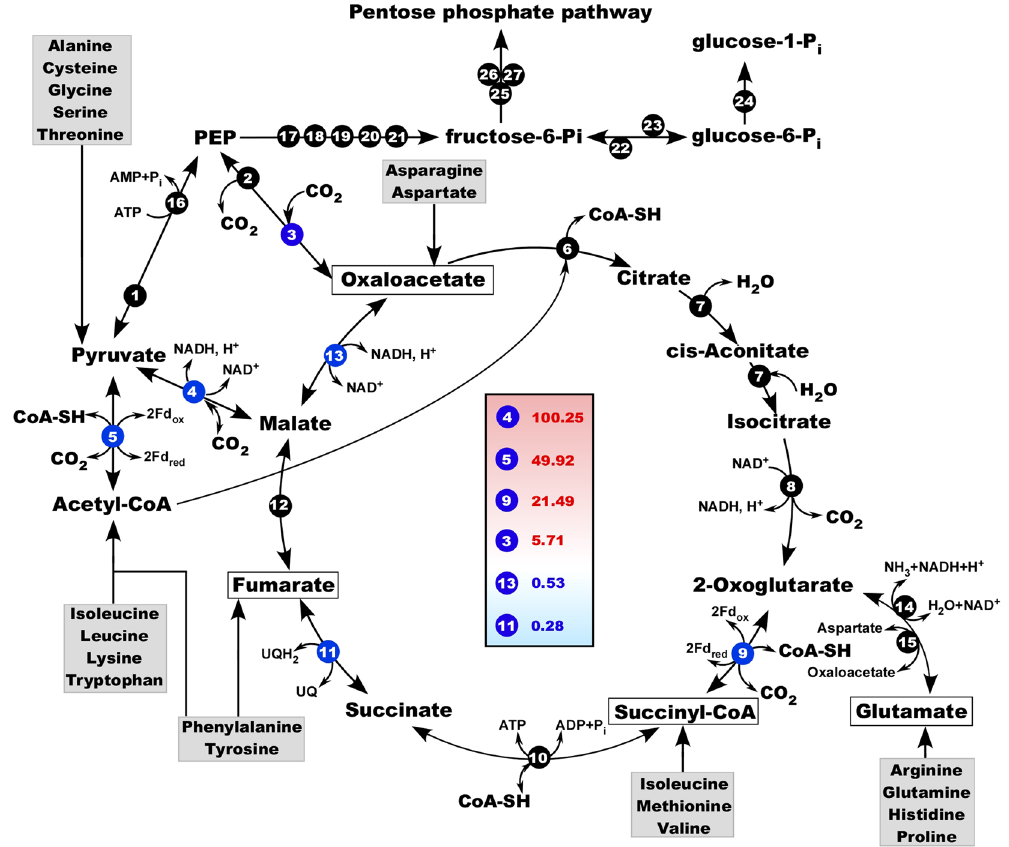
Figure 4. Proposed citric acid cycle and related enzyme reactions in F. acidiphilum Y T . The enzymes are as follows: 1, pyruvate kinase (FAD_1603); 2, PEP carboxykinase (FAD_1050); 3, PEP carboxylase (FAD_1044); 4, NAD-binding malic enzyme/malate dehydrogenase (FAD_0703); 5, pyruvate: ferredoxin oxidoreductase (FAD_0567–0568); 6, citrate synthase (FAD_1100); 7, aconitate hydratase (FAD_0701); 8, isocitrate dehydrogenase (FAD_1632); 9,2-oxoglutarate:ferredoxin oxidoreductase (FAD_0712–0713); 10, succinyl- CoA synthetase (FAD_0709–710); 11, succinate dehydrogenase (FAD_0714–0717); 12, fumarate hydratase (FAD_1630); 13, malate dehydrogenase (FAD_0718); 14, glutamate dehydrogenase (FAD_0434); 15, aspartate aminotransferase (FAD_1098); 16, phosphoenolpyruvate synthase (FAD_1233); 17, phosphoglycerate mutase (FAD_0440, FAD_1169, FAD_1350); 18,2-phosphoglycerate kinase (FAD_1810); 19, glyceraldehyde- 3-phosphate dehydrogenase (FAD_0549); 20, triosephosphate isomerase (FAD_0107); 21, fructose-2,6- bisphosphatase (FAD_0332); 22,6-phosphofructokinase (FAD_0353); 23, bifunctional phosphoglucose/ phosphomannose isomerase (FAD_0562); 24, phosphoglucomutase/phosphomannomutase (FAD_0602); 25, transketolase (FAD_1477–1476); 26, transaldolase (FAD_1201; FAD_1475); 27, ribulose-phosphate 3-epimerase (FAD_0295). Abbreviations used: Fd, electron carrier ferredoxin; NAD, nicotinamide adenine dinucleotide; CoA, Coenzyme-A; PEP, phosphoenolpyruvate; UQ, ubiquinone. Enzymes labeled in blue are potentially involved in anaplerotic assimilation of CO 2 . Their relative expression levels, analysed by RT-qPCR and indicated by the numbers in the central box, were obtained by normalization of the total RNA added and using transcripts of DNA gyrase subunit B ( gyr B) as the internal reference (value 1.0). Normalization using gyr B was additionally validated vs transcripts of gene for ribosomal L2 protein. Average normalisation data derived from triplicates with standard deviation below